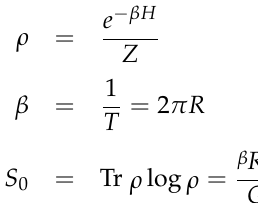
Figure 3. Two static patches in the same dS.